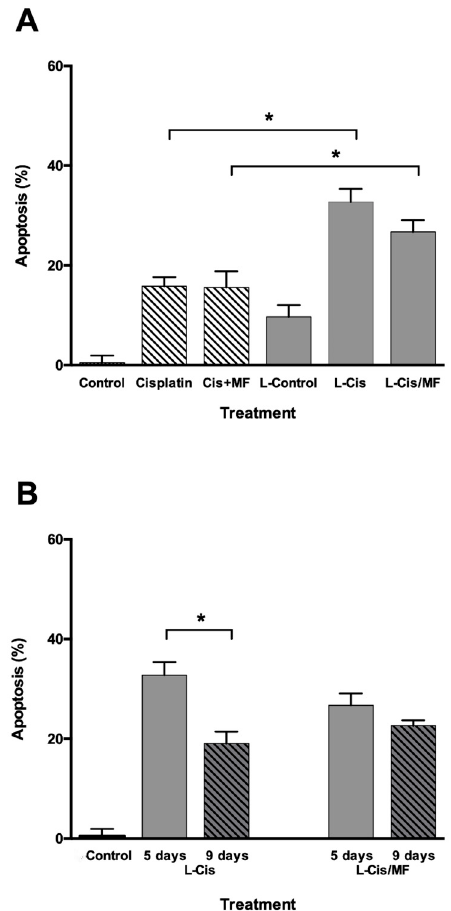
Figure5. AnalysisofapoptosisbyflowcytometryinHeLacellsatday5post-treatment: ( A )freecisplatin, Figure 5. Analysis of apoptosis by flow cytometry in HeLa cells at day 5 post-treatment: ( A ) free free cisplatin / mifepristone (Cis + MF), cisplatin-loaded liposomes (L-Cis), cisplatin / mifepristone-loaded cisplatin, free cisplatin/mifepristone (Cis + MF), cisplatin-loaded liposomes (L-Cis), liposomes (L-Cis / MF), and empty liposomes (L-Control). * p < 0.05 conventional vs. liposomal treatment. cisplatin/mifepristone-loaded liposomes (L-Cis/MF), and empty liposomes (L-Control). * p < 0.05 ( B ) Comparison of apoptosis at day 5 and 9 post-treatment with L-Cis and L-Cis / MF. * p < 0.05 day 9 vs. conventional vs. liposomal treatment. ( B ) Comparison of apoptosis at day 5 and 9 post-treatment 5. Data are expressed as the mean ± SD of three independent with L-Cis and L-Cis/MF. * p < 0.05 day 9 vs. 5. Data are expressed as the mean ± SD of three independent experiments.